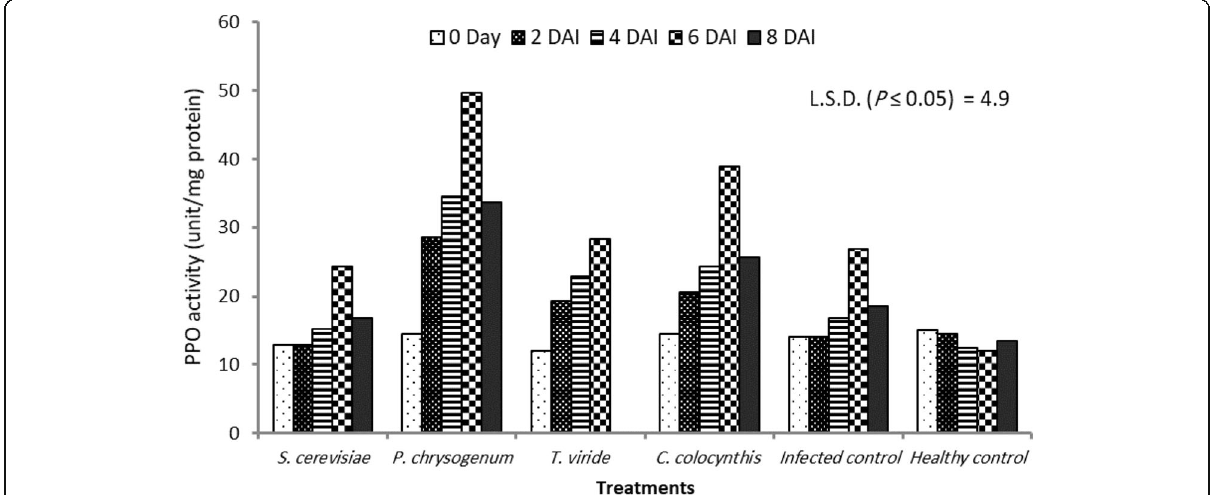
Fig. 4 Effect of application of bioagents and plant extract on polyphenoloxidase activity (PPO) in onion